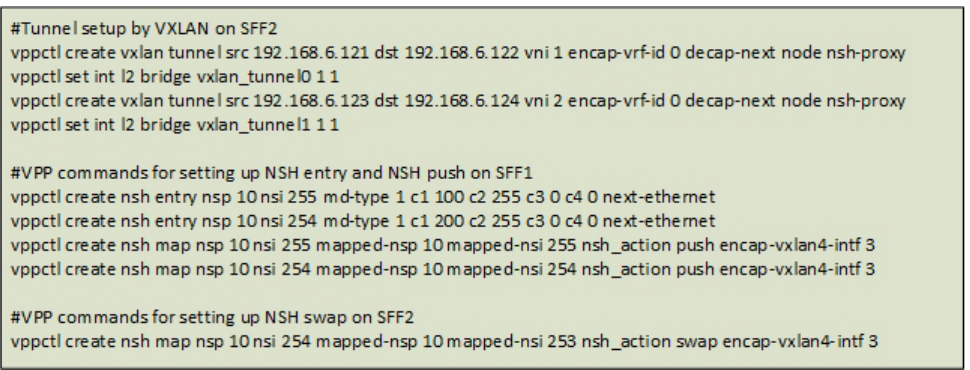
Figure 22. Examples of the NSH forwarding commands for Vector Packet Processing.